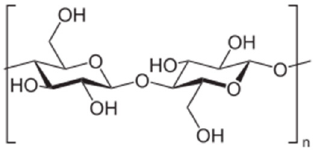
Figure 8. Structural formula of cellulose [34].